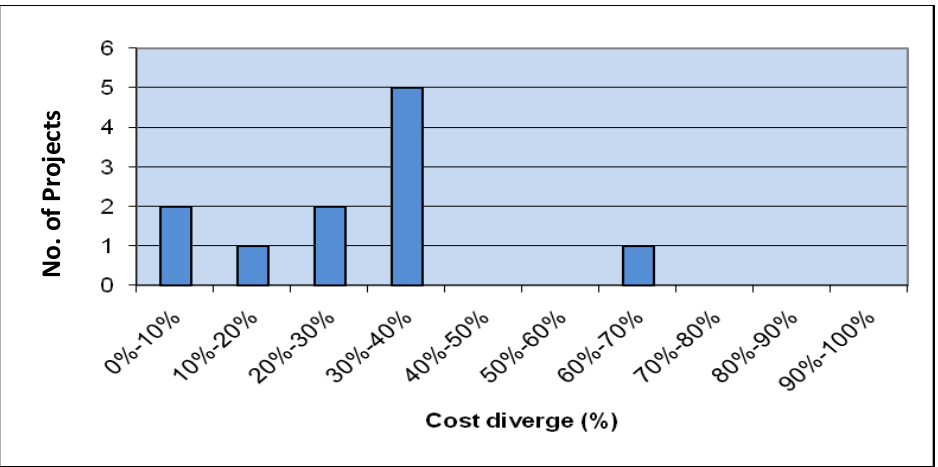
Figure 3 Cost under estimation vs. no of projects in very small road construction